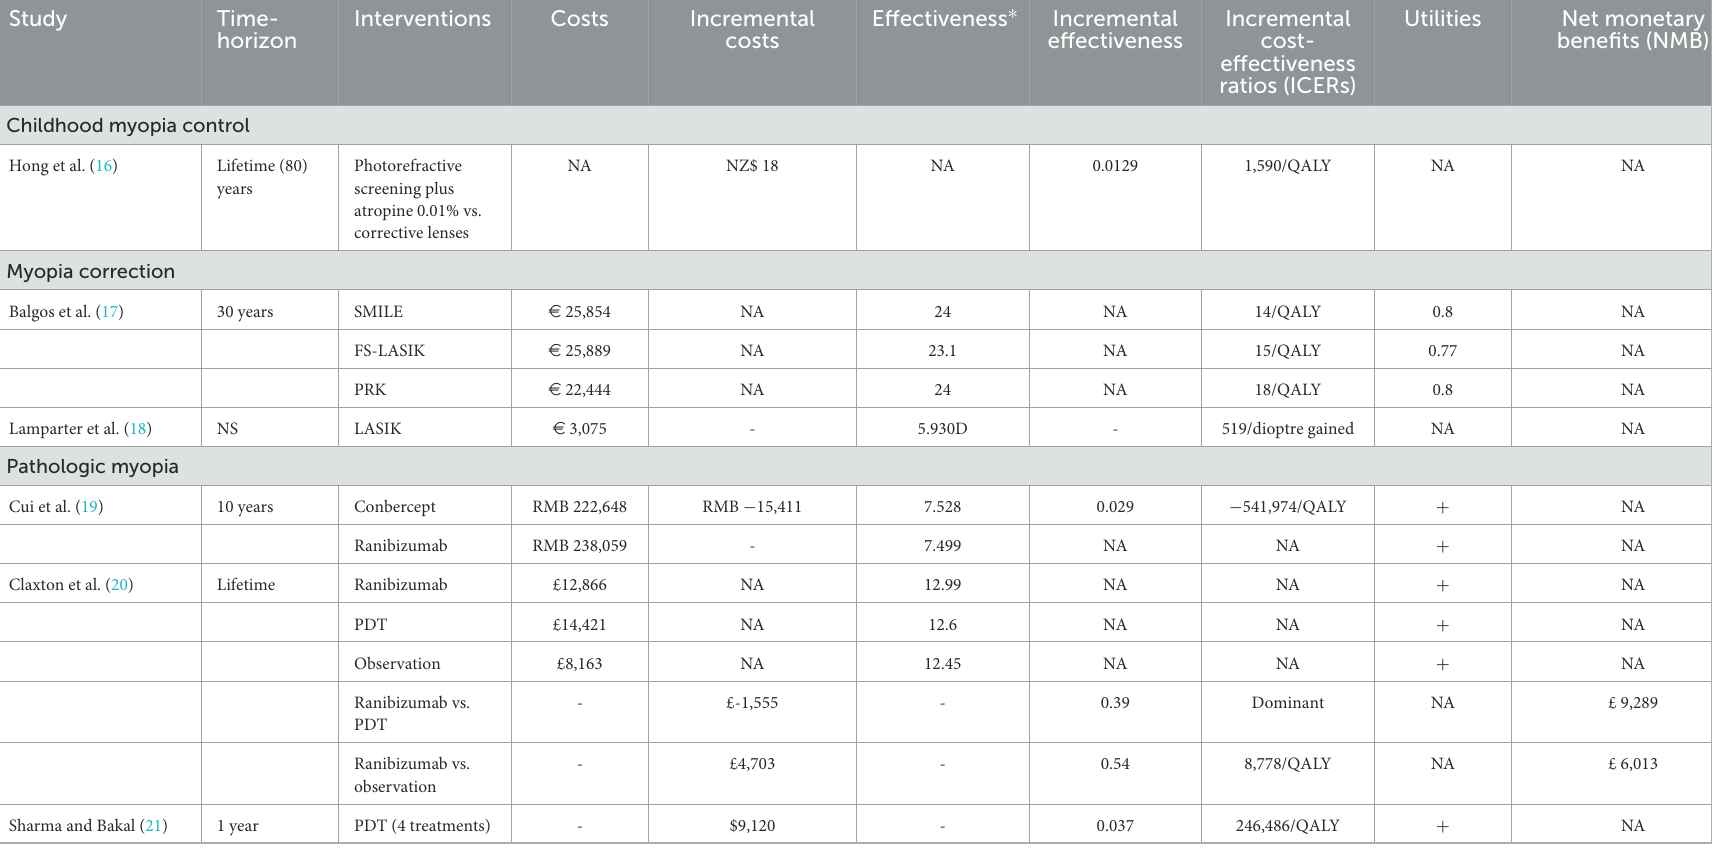
TABLE 2 Summary of outcome values from included